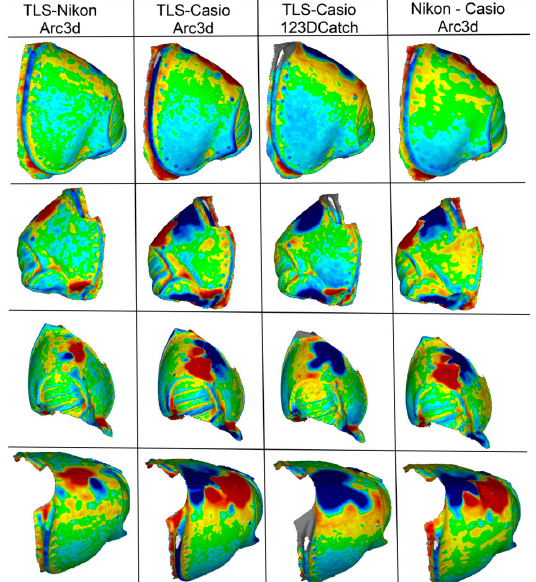
Figure 12. Right shoulder armor. Col.1: TLS-SLR (Arc3d), Col.2: TLS-Casio (Arc3d), Col.3: TLS-Casio (123D Catch),